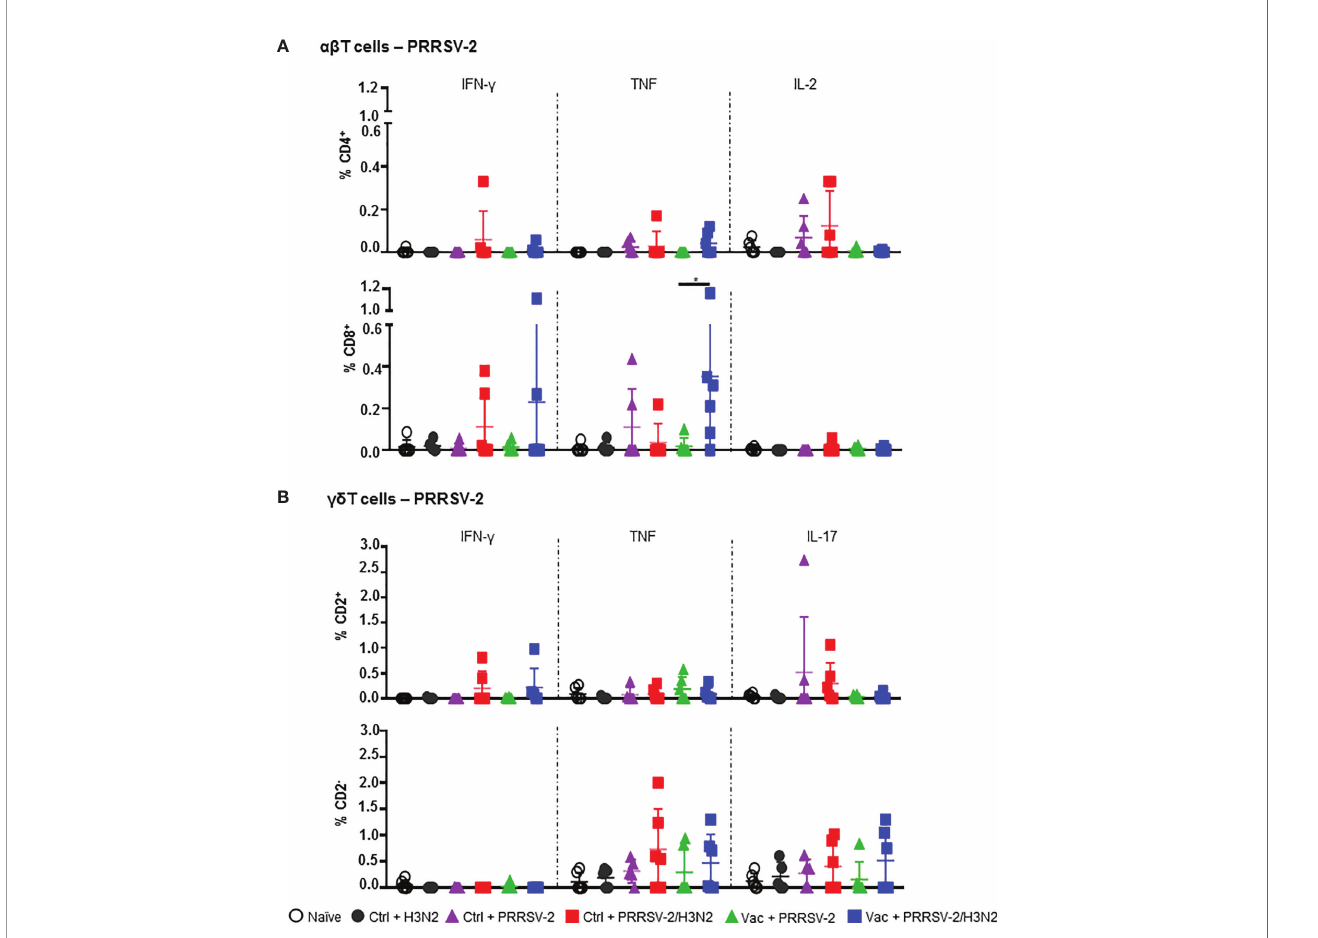
FIGURE 5 | PRRSV-2-speci fi c T cell responses in bronchoalveolar lavage. Cells isolated from BAL at 5 dpc were restimulated with PRRSV-2 (MOI 0.1) or cultured with medium. (A) Frequency of IFN- g -, TNF- and IL-2-producing CD4 + and CD8 b + T cells are shown. (B) Frequency of IFN- g -, TNF- and IL-17-producing CD2 + and CD2 - gd T cells are represented. The corrected frequencies (percentage of cytokine-producing cells subtracted with medium only) of each individual pig and the group mean ± SD are displayed (n = 5-6 per group). Comparisons between groups were made using Mann-Whitney test. Asterisk indicates signi fi cant difference (*p <